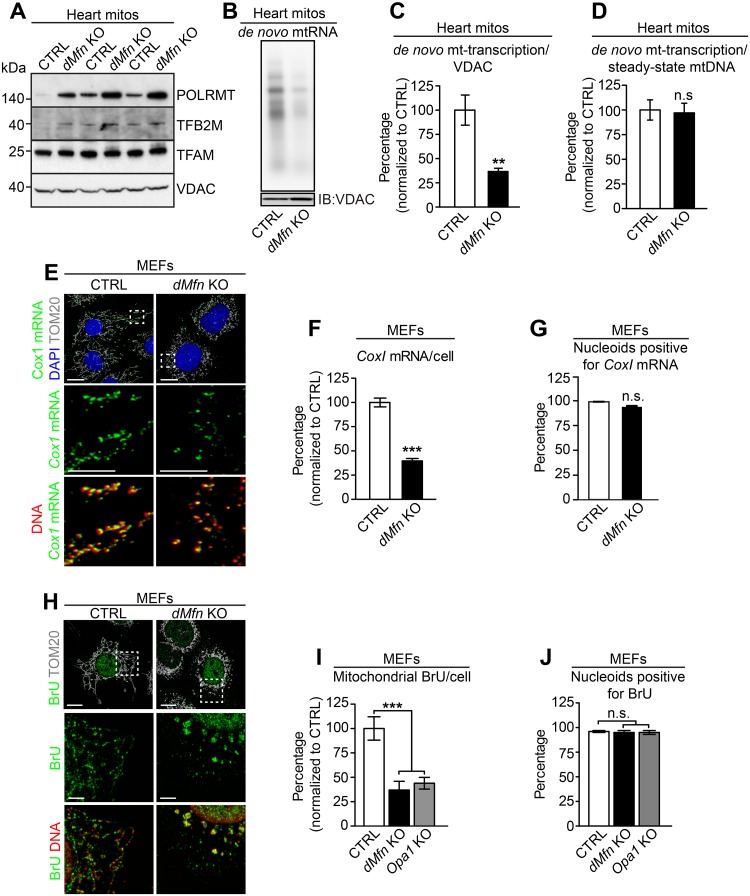
Loss of mitochondrial fusion does not affect mtDNA transcription.(A) Western blot analysis of steady-state levels of proteins essential for mitochondrial transcription in heart mitochondria from control and dMfn heart KO animals at 5–6 weeks of age (n = 3 for each genotype). (B) Representative image of a mitochondrial de novo transcription assay with heart mitochondria. Mitochondrial VDAC levels were determined by western blot analysis and used as loading control. Multiple control (n = 6) and dMfn KO (n = 5) heart mitochondrial samples were analyzed at 4 weeks of age. (C) Quantification of mitochondrial de novo transcription related to VDAC protein levels in control (n = 6) and dMfn heart KO (n = 5) mitochondria. (D) Quantification of mitochondrial de novo transcription related to the steady-state levels of mtDNA of control (n = 6) and dMfn KO (n = 5) heart mitochondria. (E) Representative fluorescence in situ hybridization of images visualizing the mitochondrial CoxI mRNA, followed by immunocytochemistry to detect mtDNA and TOM20 protein in control and dMfn KO MEFs. Dashed boxes specify the areas of magnification. Scale bars represent 10 μm for overview image and 5 μm for zoom-in images. Staining patterns were determined in five independent experiments per genotype. (F) Quantification of CoxI mRNA in control (n = 17) and dMfn KO (n = 15) by using stacked confocal images from individual MEFs. (G) Quantification of nucleoids positive for CoxI mRNA by using stacked confocal images from control (n = 15) and dMfn KO (n = 14) MEFs. (H) Representative images of immunocytochemistry to detect BrU labeling of newly synthesized mitochondrial RNA, mtDNA and TOM20 protein in control and dMfn KO MEFs. Dashed boxes specify the areas of magnification. Scale bars represent 10 μm for overview image and 5 μm for zoom-in images. Staining patterns were determined in five independent experiments per genotype. (I) Quantification of BrU-labeled mitochondrial RNAs by using stacked confocal images from control (n = 15), dMfn KO (n = 15), and Opa1 KO (n = 15) MEFs. (J) Quantification of BrU-positive nucleoids by using stacked confocal images from control (n = 15), dMfn KO (n = 18), and Opa1 KO (n = 15) MEFs. Error bars indicate ± SEM. For (C, D, F, and G), Student T-test; **, P < 0.01; ***, P < 0.001. For (I and J), one-way ANOVA using Turkey’s multiple comparison test relative to control; ***, P < 0.001; n.s., non-significant difference.